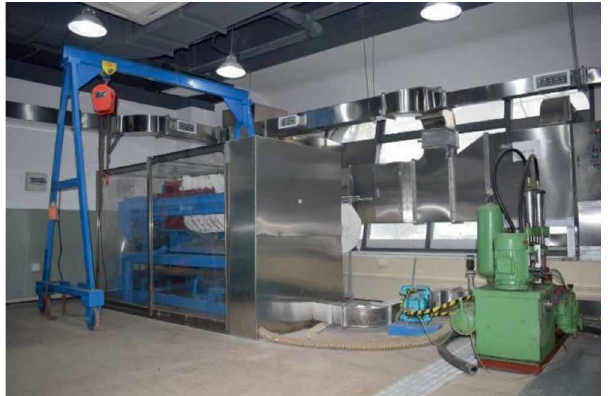
Figure 1: Dewatering equipment of municipal